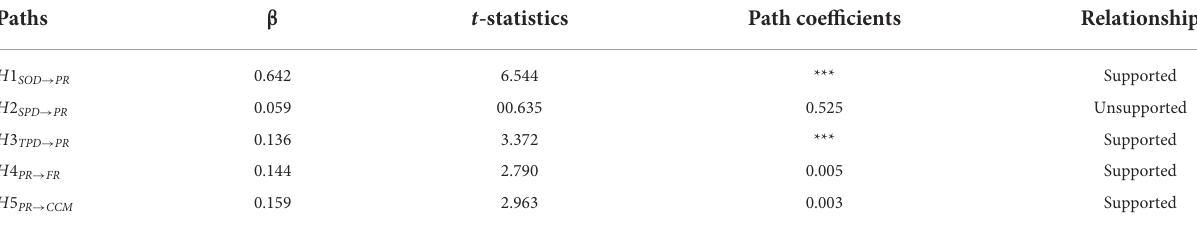
TABLE 4 Confirmation of proposed